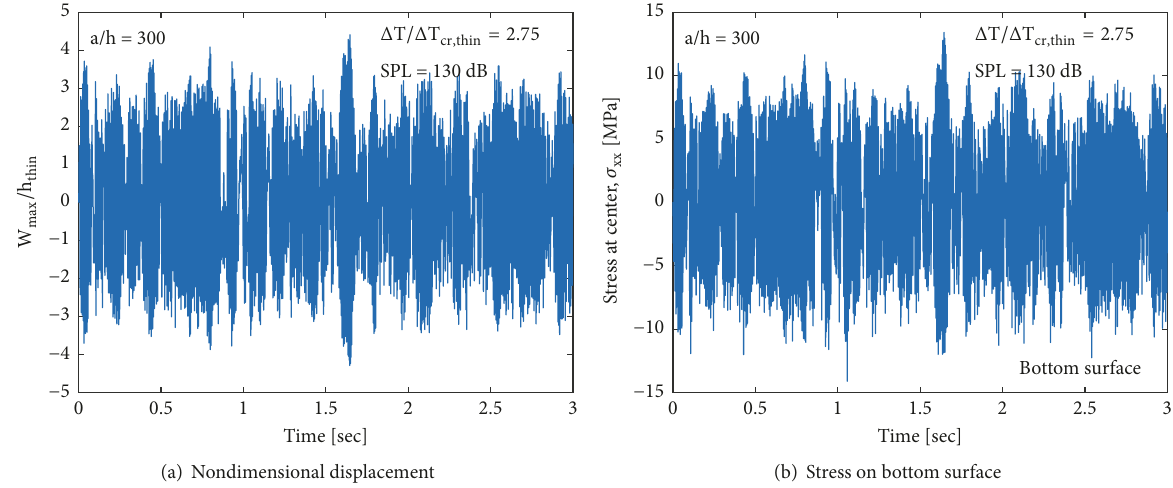
Figure 8: Large random vibrations about flat position (a/h = 300).